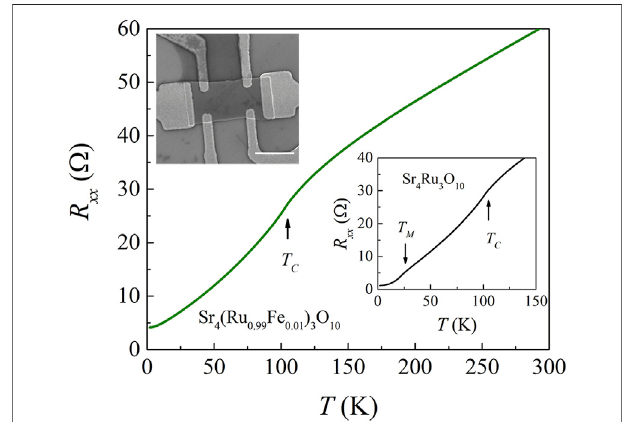
FIGURE 1 | The temperature dependence of the zero- fi eld resistance R xx ofa45-nm-thickSr 4 (Ru 0.99 Fe 0.01 ) 3 O 10 nanosheet.Insets(top)SEMimage of the Sr 4 (Ru 0.99 Fe 0.01 ) 3 O 10 nanosheet with electrodes, scale bar: 3 μ m. (Bottom) R xx – T curve of a pure Sr 4 Ru 3 O 10 nanosheet with the thickness of about 35 nm.